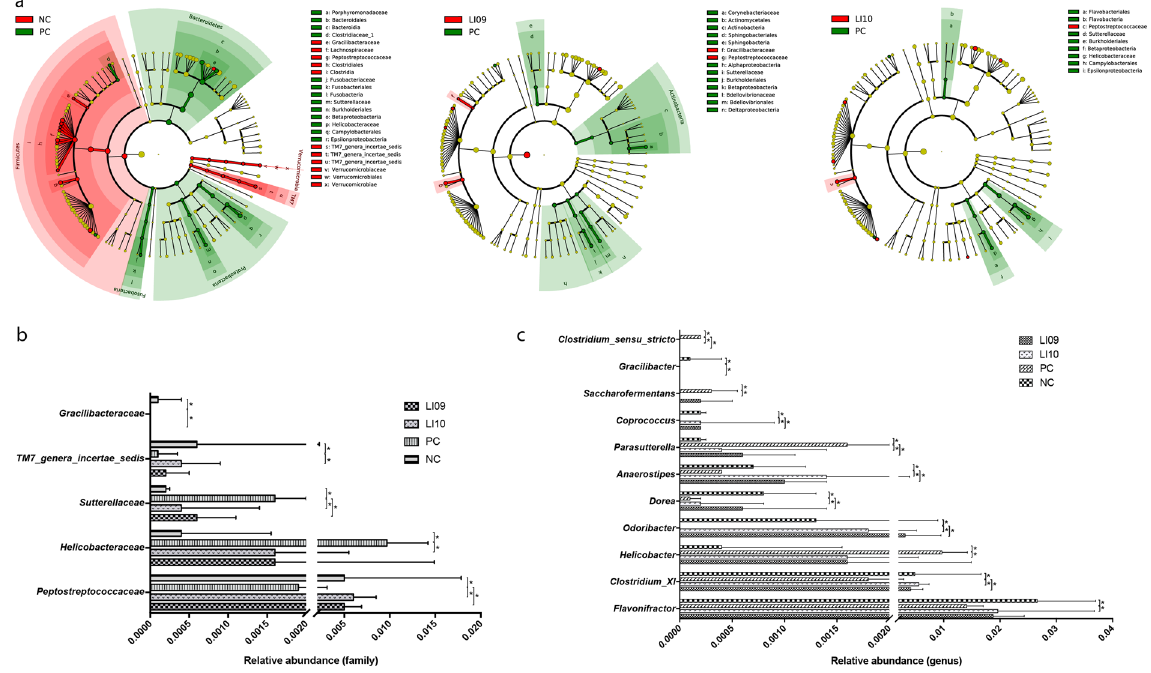
Figure 5. Effects of pretreatment with B. pseudocatenulatum LI09 or B. catenulatum LI10 on the alterations of gut bacterial taxonomic abundance during D-GalN-induced acute liver injury. ( a ) Bacterial taxa identified as differentially abundant between two groups analysed by linear discriminant analysis effect size (LEfSe). The bacterial taxa of the NC, LI09 and LI10 groups were compared with those of the PC group at different levels. Green indicates those bacterial taxa whose abundance were higher in the PC group, and red indicates those bacterial taxa whose abundance were higher in the other group. In addition, yellow indicates those bacterial taxa whose abundance show non-significant differences between the two groups. ( b ) The relative abundance at the bacterial family level in the LI09 or LI10 group was compared with that in the PC group. ( c ) The relative abundance at the bacterial genus level in the LI09 or LI10 group was compared with that in the PC group. Values are expressed as the median with interquartile range. * p < 0.05 compared with the PC